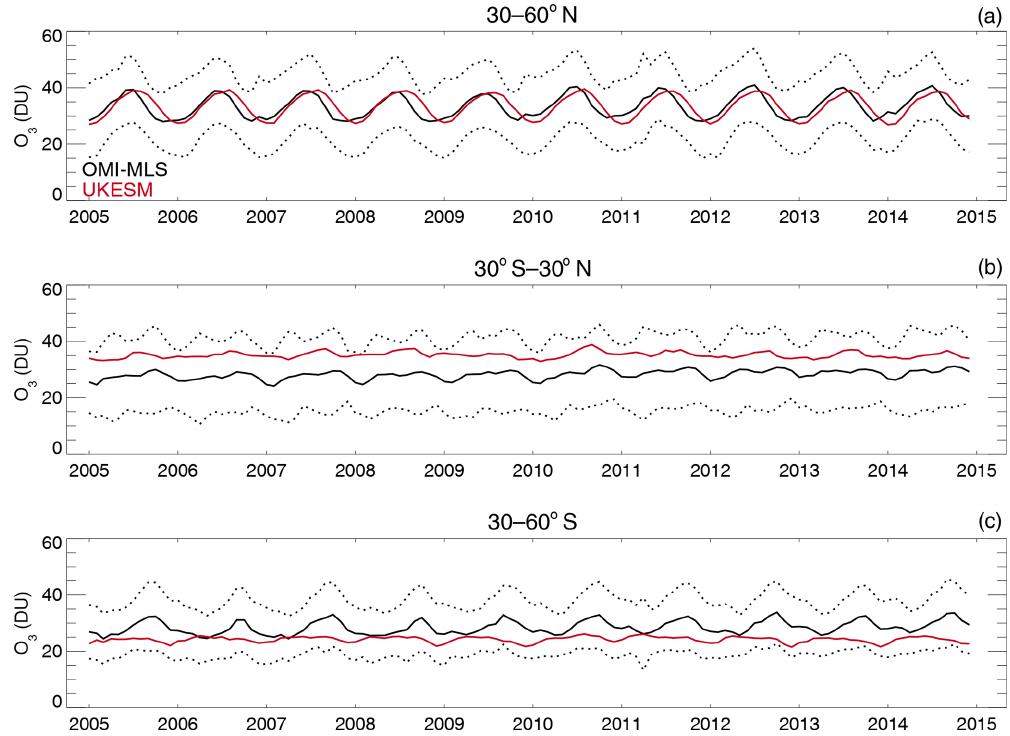
Figure 15. Tropospheric column O 3 (DU) zonal time series (30–60 ◦ N – a , 30 ◦ N–30 ◦ S – b , 30–60 ◦ S – c ) for the ND simulation (red) and OMI-MLS (black). Dashed lines represent the satellite uncertainty range ( ± 2 × SD).